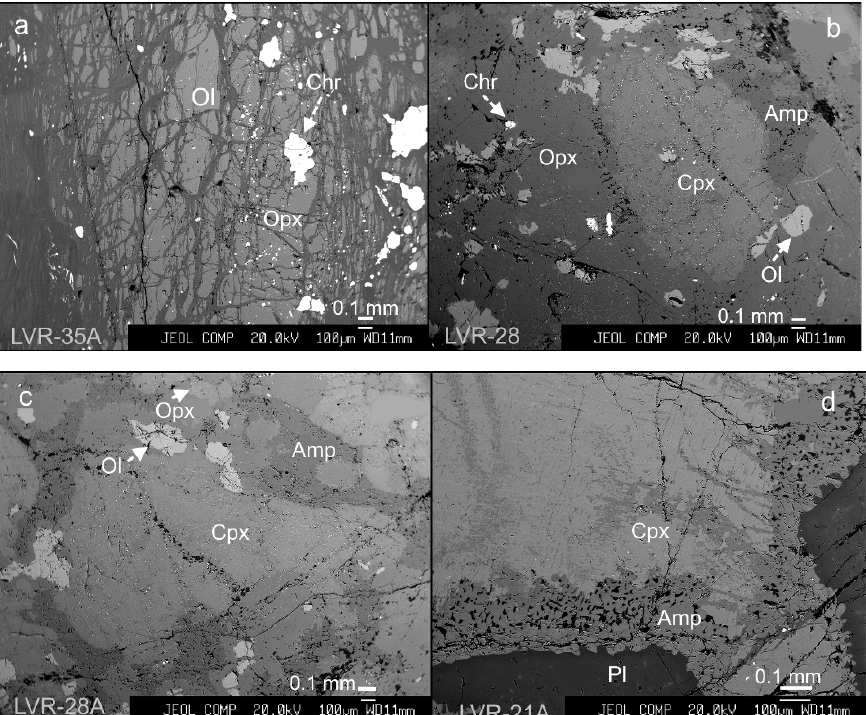
Figure 7. ( a – d ) Back-scattered electron (BSE) image of a sample of texturally massive dunite from Zone I, only slightly serpentinized, grading to harzburgite ( a ). It consists mainly of magnesian olivine (Ol) with subordinate grains of Opx and abundant grains of chromian spinel (Chr). ( b , c ) display occurrences in Zone III of small grains of recurrent olivine (Ol) adjacent to large grains of magnesian clinopyroxene (Cpx) associated with orthopyroxene (Opx). The term recurrent expresses clearly the fact that olivine appears anew after an interval in which it had ceased crystallizing. A reaction rim of amphibole (Amp) of pargasitic composition, also in Zone III, contains submicrometric symplectitic inclusions of quartz (black in ( d )). Such rims develop in clinopyroxene (Cpx) along its contact with intercumulus plagioclase (Pl).